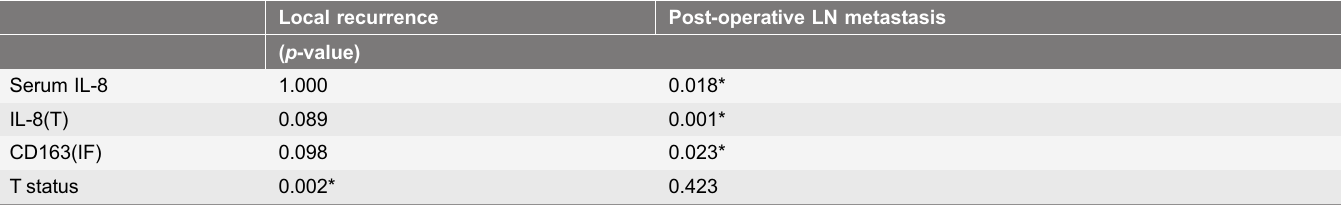
Table 2. Relationship between mode of relapse and IL-8, CD163 +